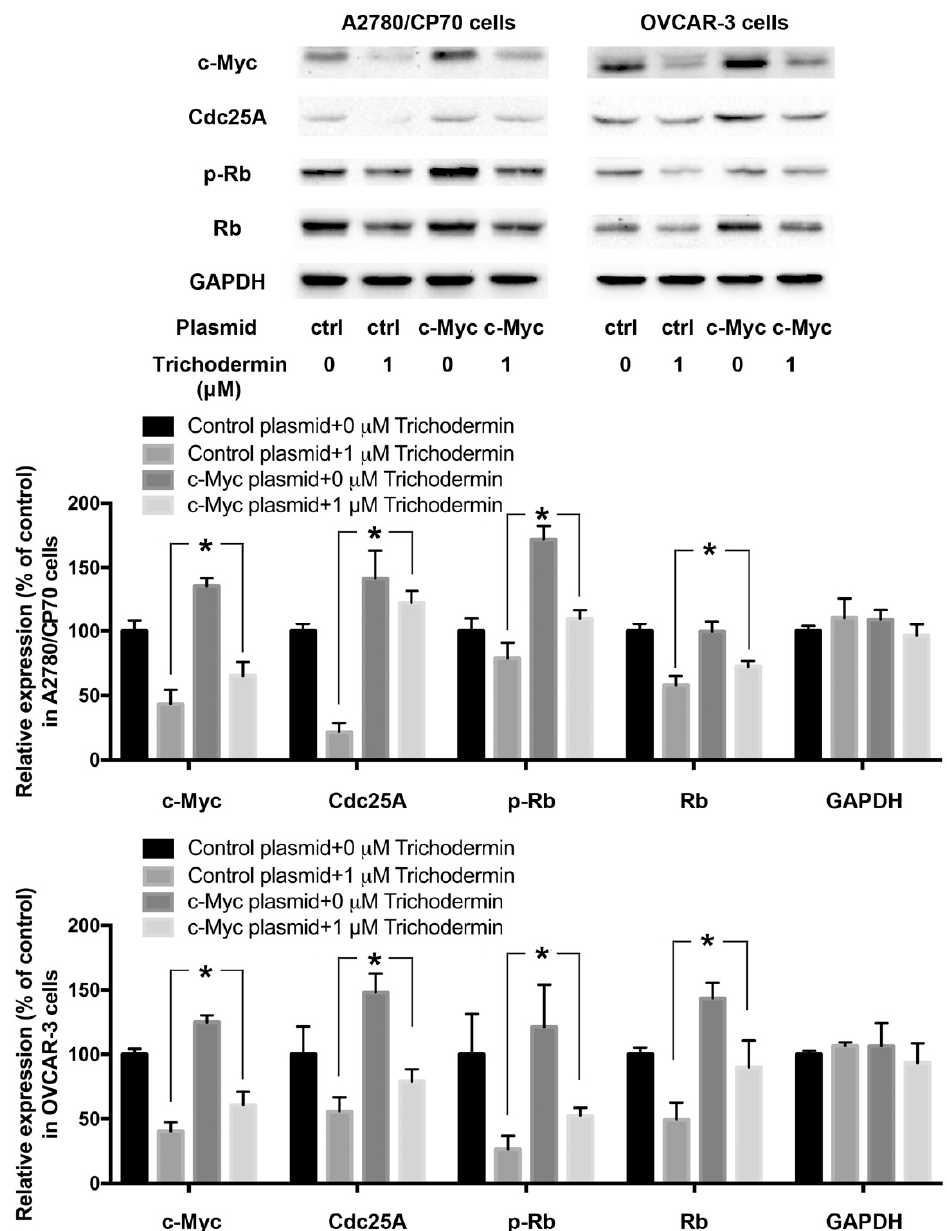
Figure 5. Overexpression of c-Myc attenuated trichodermin-induced suppression of c-Myc, Cdc25A, phosphor-retinoblastoma protein (p-Rb), and Rb in A2780/CP70 and OVCAR-3 cells. Glyceraldehyde-3-phosphate dehydrogenase (GAPDH) served as the loading control. * p < 0.05 compared with the specific group.